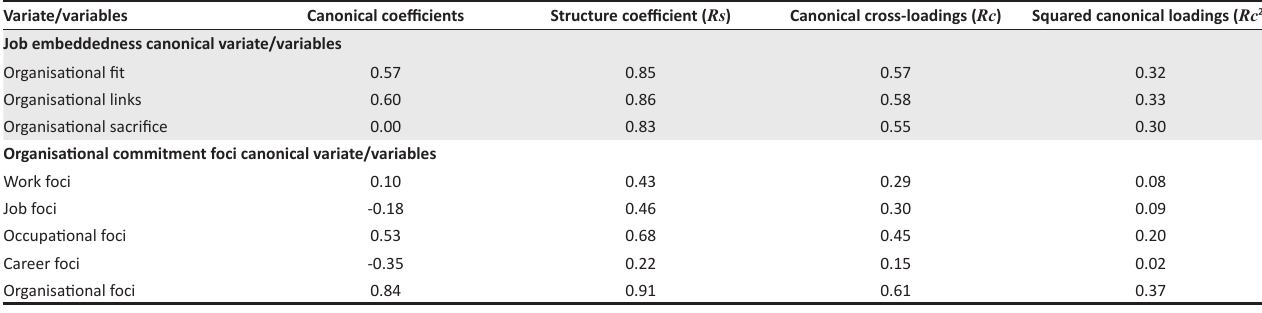
TABLE 2: Results of the standardised canonical correlation analysis for the first canonical function.